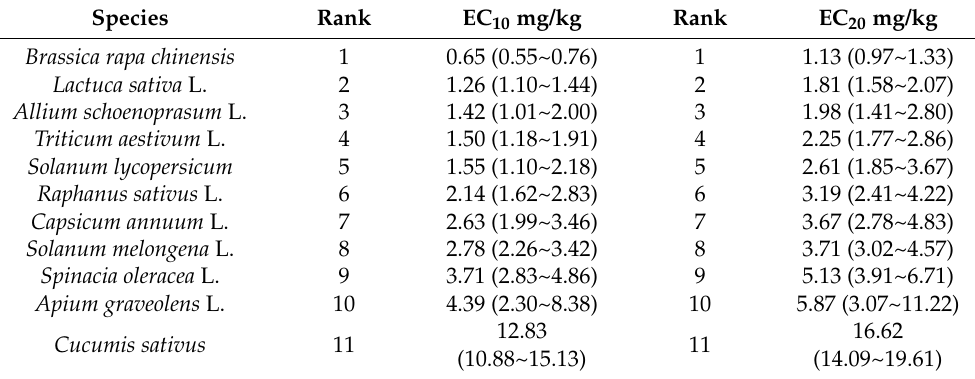
Figure 1. The inhibition rate of Cr(VI) on root elongation of 11 plants: ( a ) leafy vegetables; ( b ) solana- ceous vegetables; ( c ) wheat, gourd vegetable and stem vegetable. Bars represent standard error ( n = 3). Table 3. Inhibition effects of Cr(VI) on root elongation of 11 terrestrial